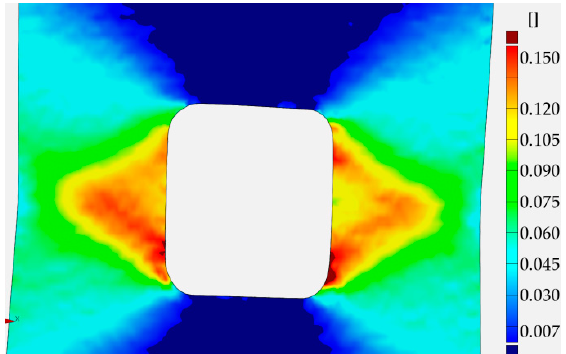
Figure 30. Distribution of strain field (DIC) in samples with square holes made of 41Cr4 + QT steel.